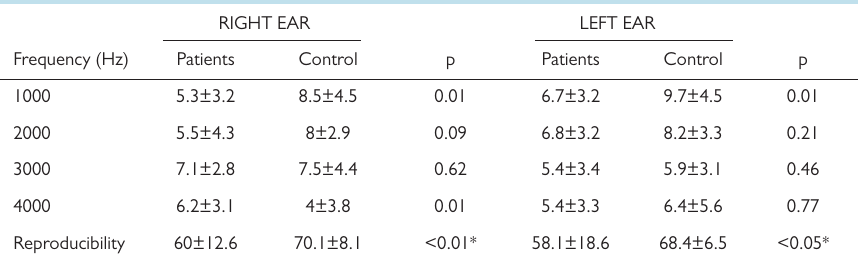
Table 3. TEOAE SNR levels